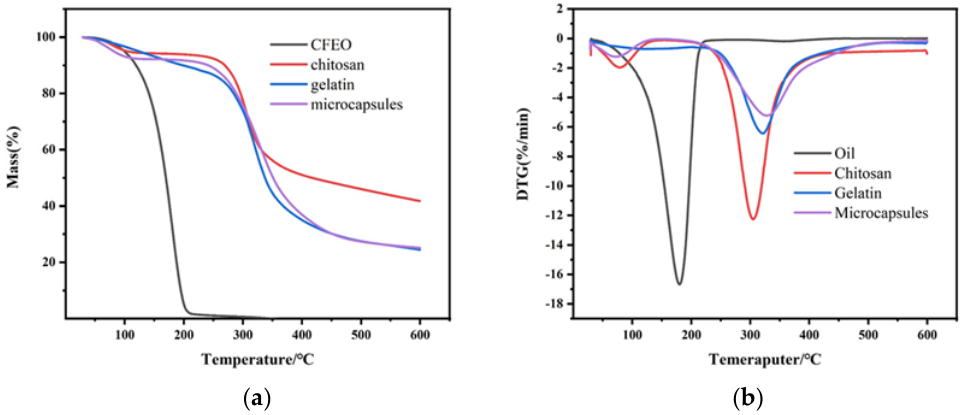
Figure 5. TGA ( a ) and DTG ( b ) curves for CFEO, chitosan, gelatin and CFEO microcapsules.